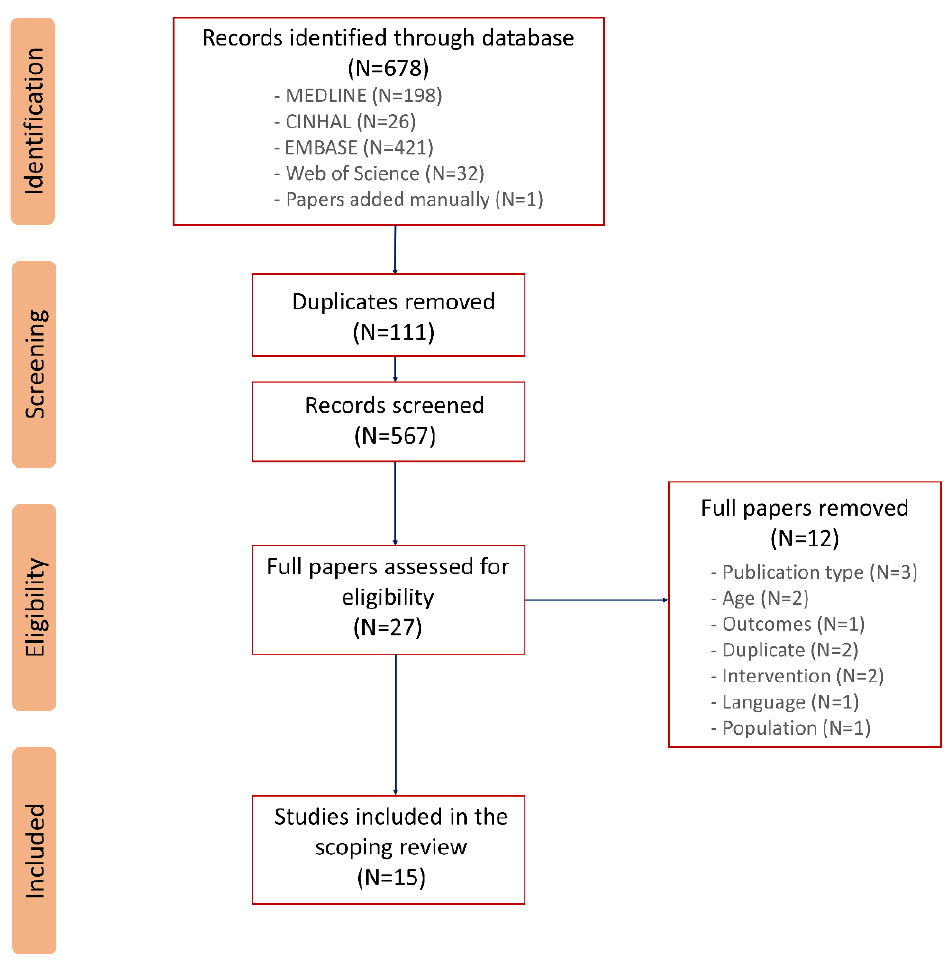
Figure 1. Prisma flow chart of the selection process.